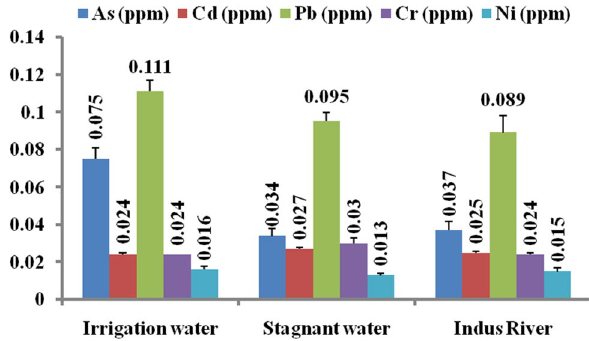
Fig. 2 Graphical representa- tion of different heavy metals levels in different water sources of the trans-Himala- yan high-altitude